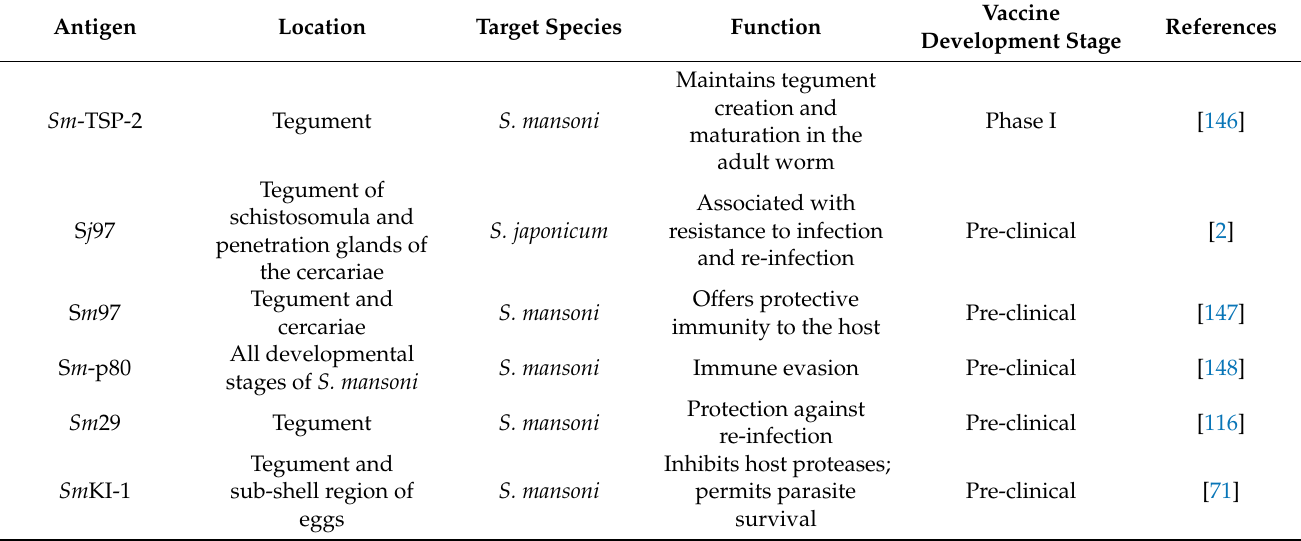
Table 3. Anti-schistosomal vaccine